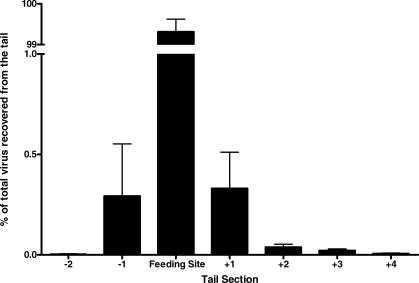
Movement of Virus from Mosquito Feeding Site on TailMost of the virus inoculated by mosquitoes was recovered from the tail section(s) that the mosquito probed and fed in (feeding site). Percent of total virus recovered from each tail section. Data from each mouse tail were shifted to align feeding sites. If mosquitoes probed or fed in two sections, those sections were summed and combined into one feeding site. Tail sections toward the tail tip in relation to the feeding site are labeled −1 and −2. Tail sections toward the body in relation to the feeding site are labeled +1 to +4. Includes data from orally and parenterally infected Cx. tarsalis, Ae. japonicus, and Ae. triseriatus feeding on a mouse tail.